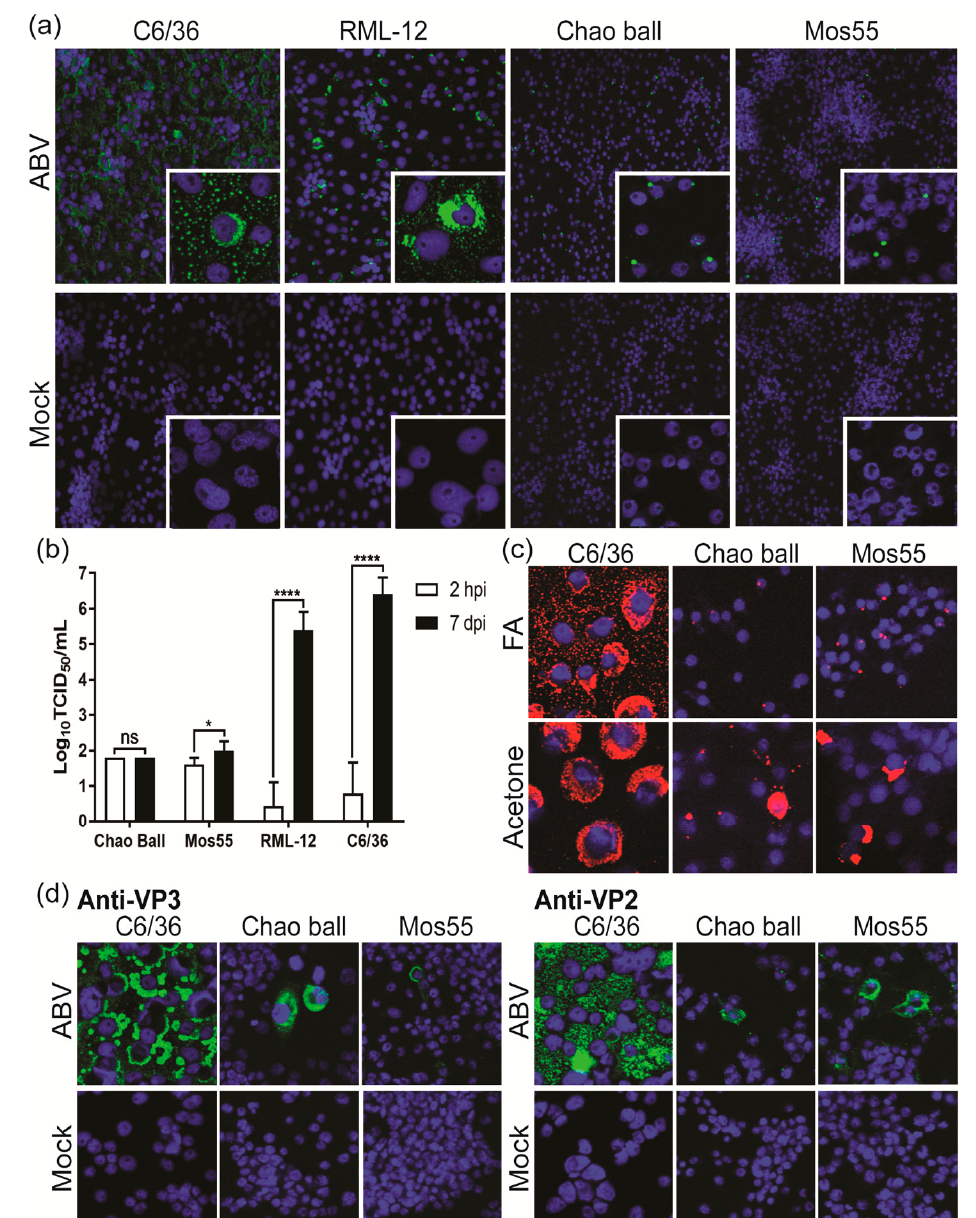
Figure 8. ABV replication in mosquito cell lines. ( a ) IFA performed on mosquito cells infected with ABV or mock infected (media only) fixed with 4% formaldehyde (FA) and 0.5% Triton X-100 at 7 dpi and immunolabeled for dsRNA (green) and nuclei (blue). Main panel images taken at 40x and inset at 63x magnifications. ( b ) Mean titers in supernatants harvested from mosquito cells at 2 hpi (white) and 7 dpi (black). Error bars represent standard deviations between three replicates. Statistical significance was calculated by t tests using the Holm–Sidak method, with alpha = 0.05. Each row was analyzed individually, without assuming a consistent SD. ****, p < 0.0001; *, p < 0.05; ns, not significant. ( c ) Localization of dsRNA (red) in ABV-infected mosquito cells fixed with either 100% acetone, or 4% formaldehyde + 0.5% Triton X-100. DsRNA (red); nuclei (blue). Images taken at 63x magnification. ( d ) ABV or mock-infected mosquito cells stained with VP3- and VP2-specific mAbs. ABV protein (green); nuclei (blue). Images taken at 40x magnification. C6 / 36, RNAi-deficient Ae. albopictus ; RML-12, RNAi-competent Ae. albopictus ; Chao Ball, Culex tarsalis ; Mos55, Anopheles gambiae